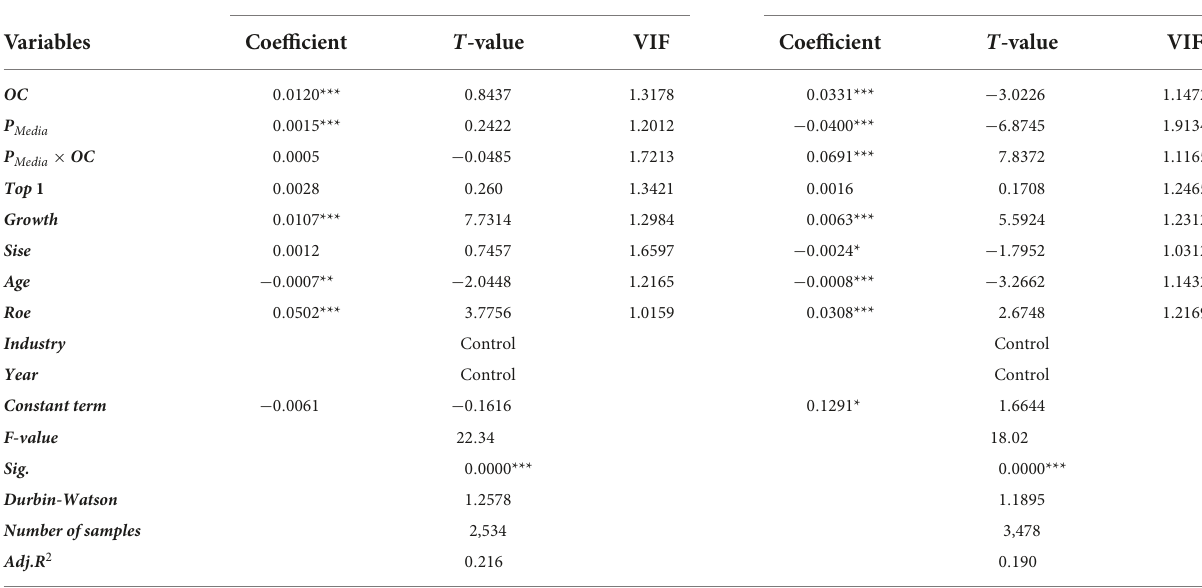
TABLE 6 Regression results of positive media reports under different marketization